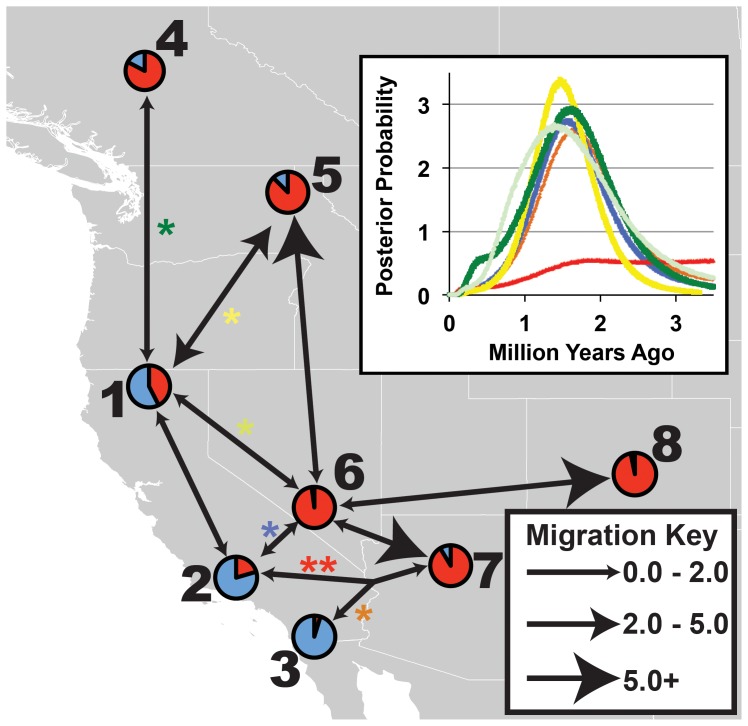
Patterns of migration and divergence between populations in Poecile gambeli.Results from coalescent-based isolation with migration (IMa) analyses. Population pie charts shown as a proportion of clade assignment (from Fig. 2). Effective migration (2 Nm) represented by arrows between populations (see migration key). Inset shows divergence time between clades (pairwise comparisons for inset marked with an asterisk on map, asterisks and posterior distributions of inset are colored to indicate population comparisons). The single comparison that reached a plateau in divergence time estimates is marked with a double asterisk. Throughout the discussion, populations referred to as northern (or southern) indicate populations 1, 4, 5 (or 2, 3, 6, 7, 8).